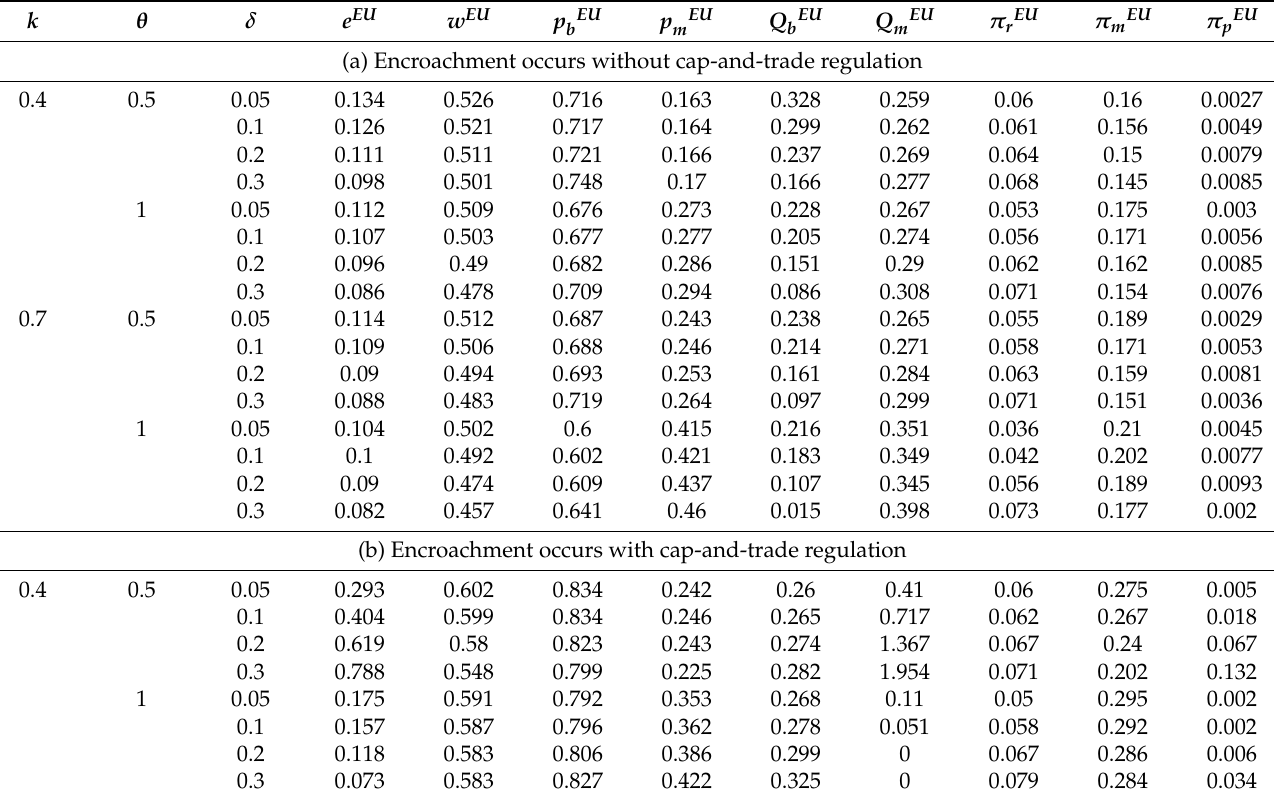
Table 2. Equilibrium outcomes of the encroachment